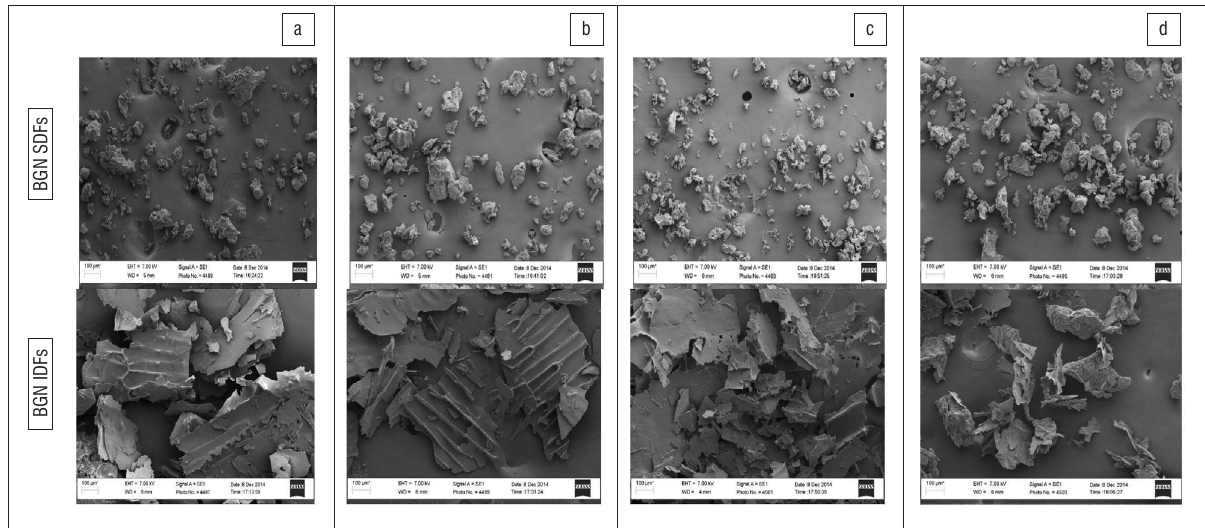
Figure 2: Scanning electron micrographs of soluble and insoluble dietary fibres (SDFs and IDFs, respectively) isolated from four varieties of Bambara groundnut (BGN). (a) black-eye, (b) brown-eye, (c) brown, (d)